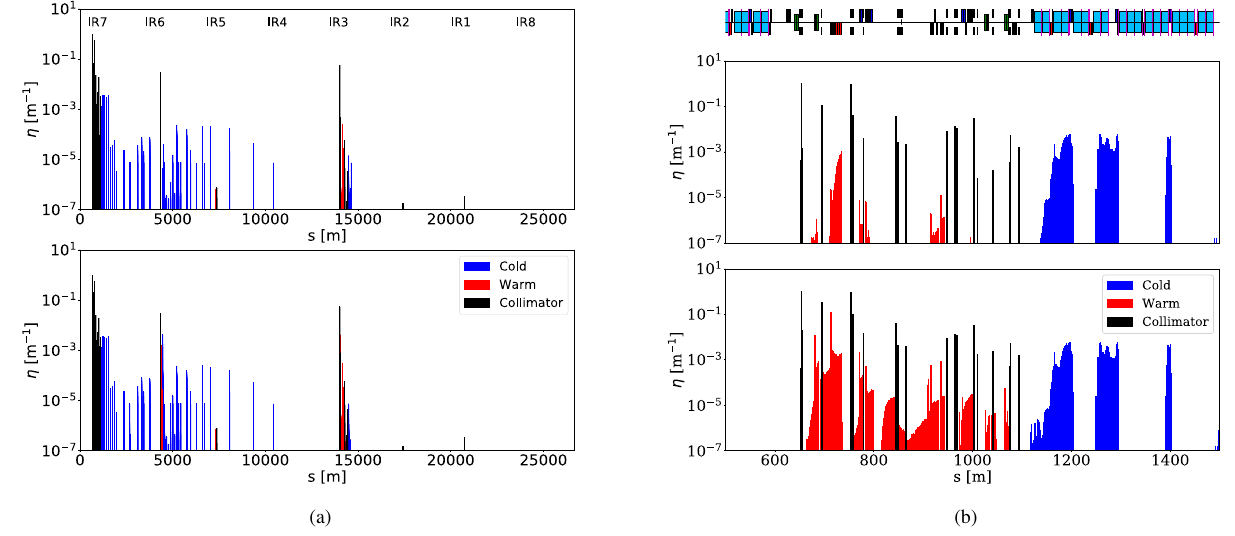
FIG. 6. B2 horizontal full ring (left) and IR7 zoom (right) loss map for 2018 208 Pb 82 þ ion colliding optics without (top) and with (bottom) the tracking of the protons generated at